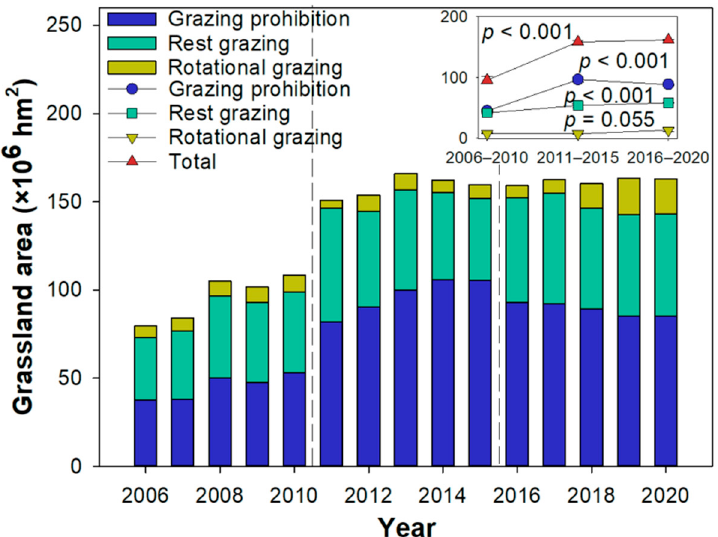
Figure 6. Area of grazing prohibition, rest grazing, and rotation grazing in Chinese grasslands from 2006 to 2020.